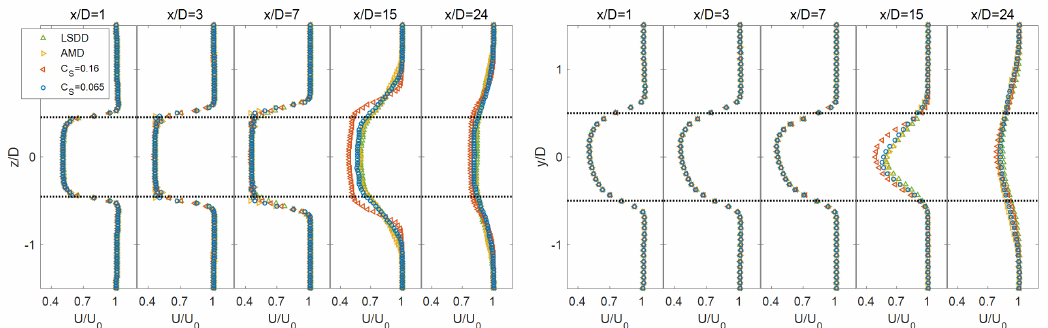
Figure 4. Vertical ( left ) and lateral ( right ) profiles of the normalized mean streamwise velocities ( U / U 0 ) through the turbine equator at x / D = 1,3,7,15,24 downwind of the turbine for different SGS